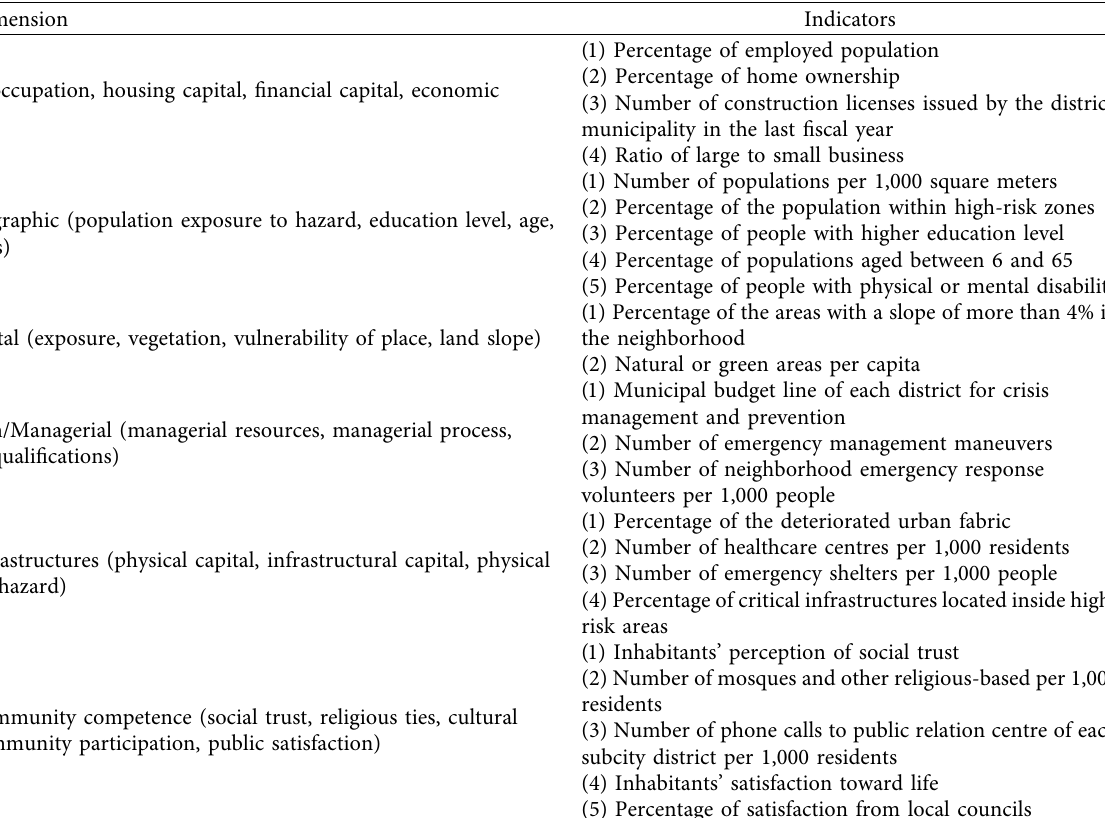
Table 1: Summary of community seismic resilience indicators for each dimension and the main attributes of the dimensions. [28].